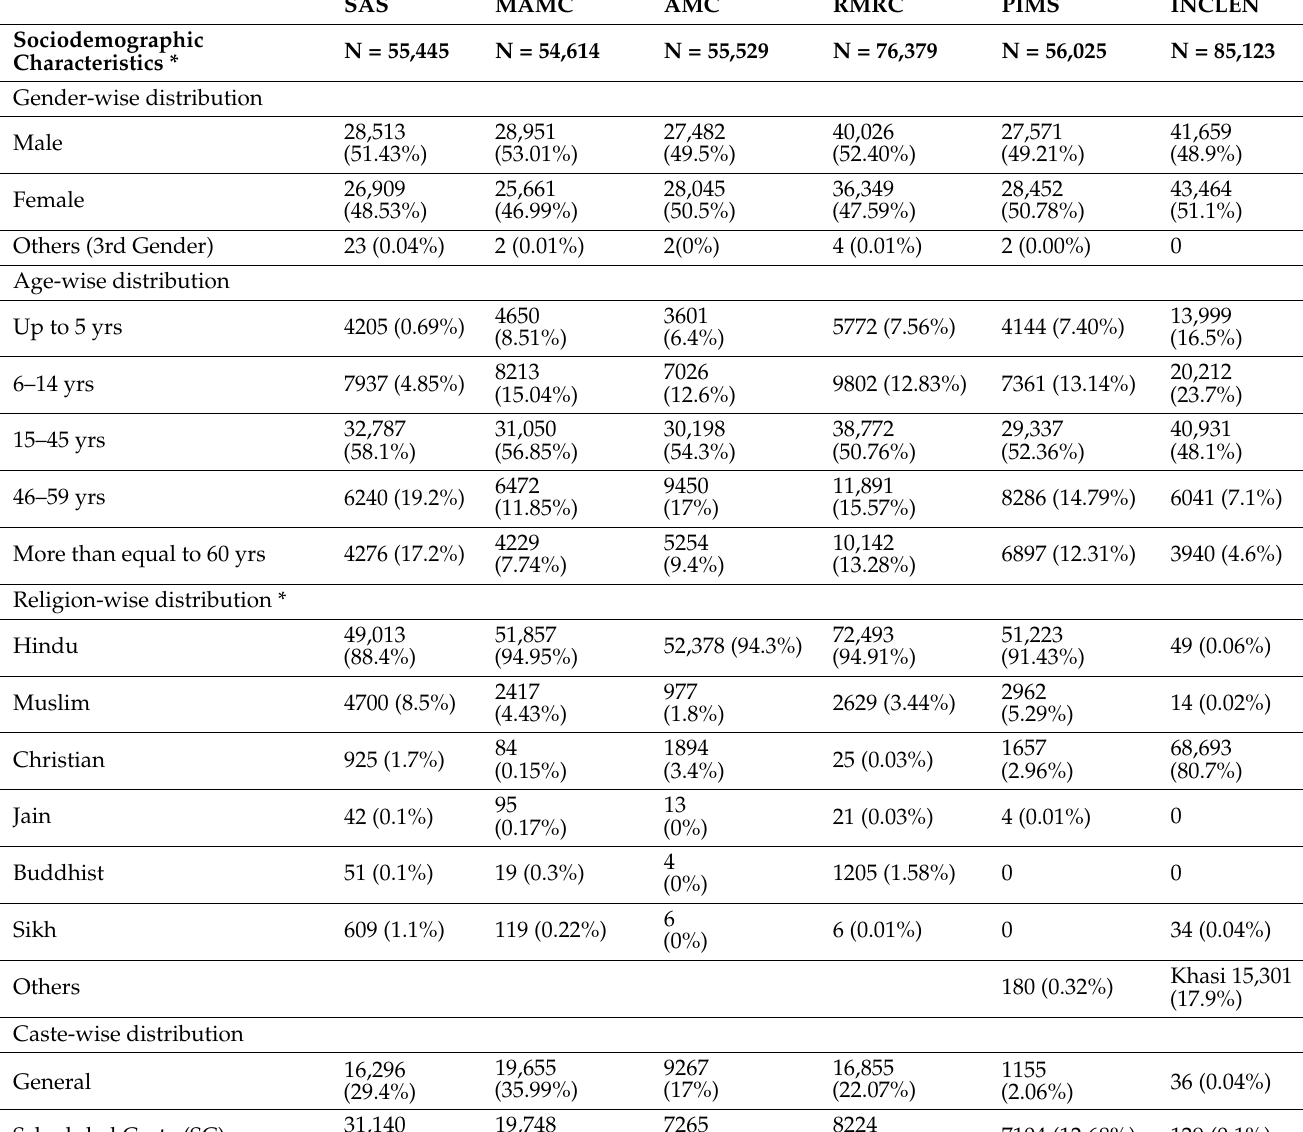
Table 1. Sociodemographic characteristics of the study